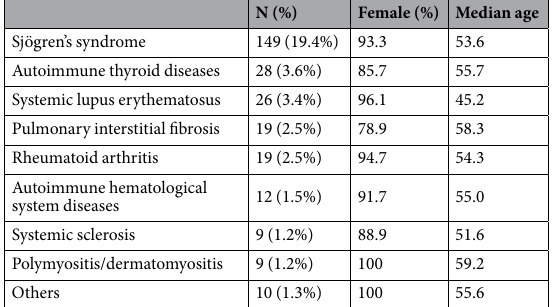
Table 2. Extrahepatic autoimmune diseases of PBC patients from January 2001 to July 2016.